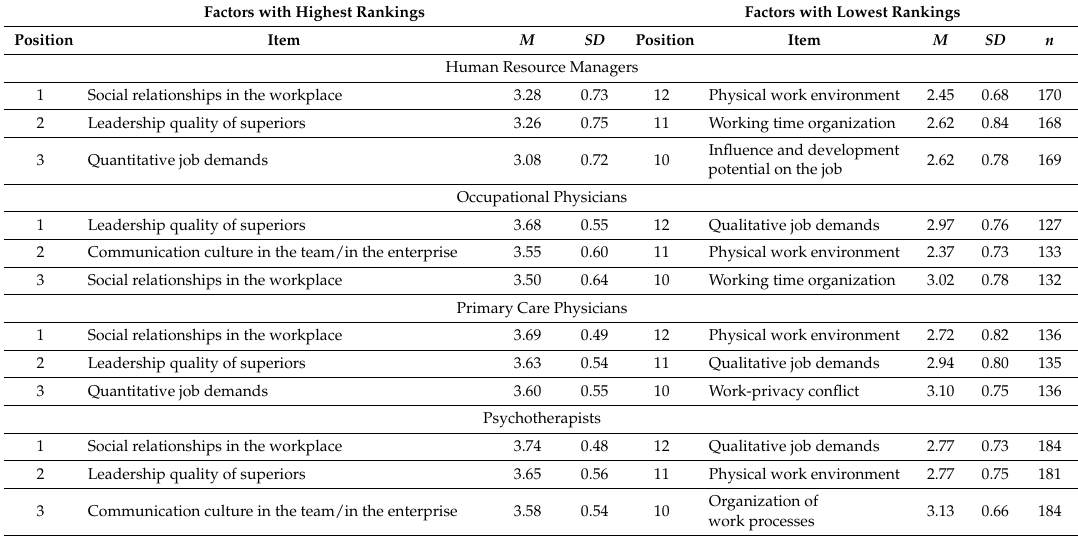
Table 5. Most important and least important work-related factors for the development of (stress-associated) mental disorders according to the ratings of the investigated groups of